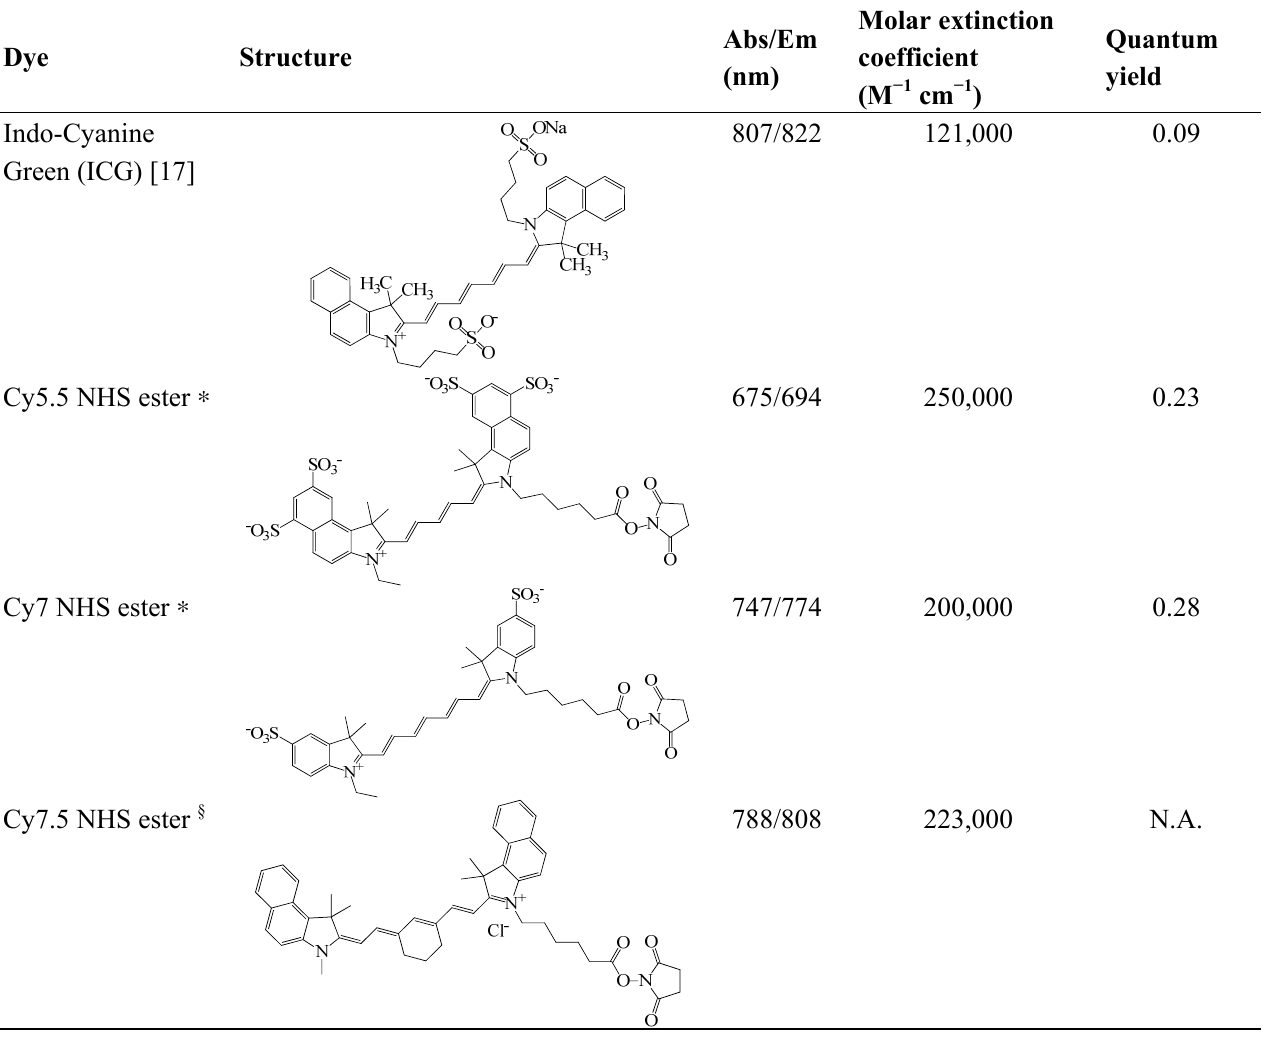
Table 2. Structures and optical characteristics of commercial NIR cyanine